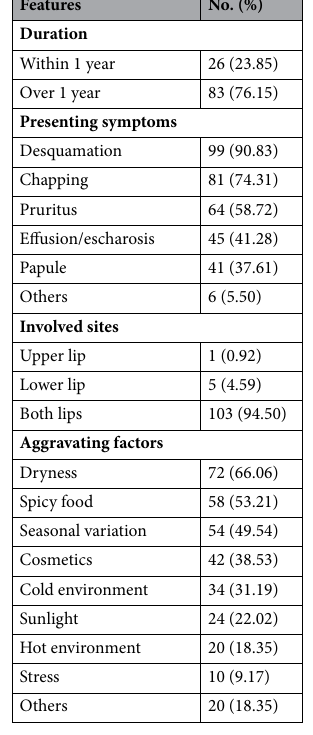
Table 2. Clinical features of 109 patients with chronic cheilitis.